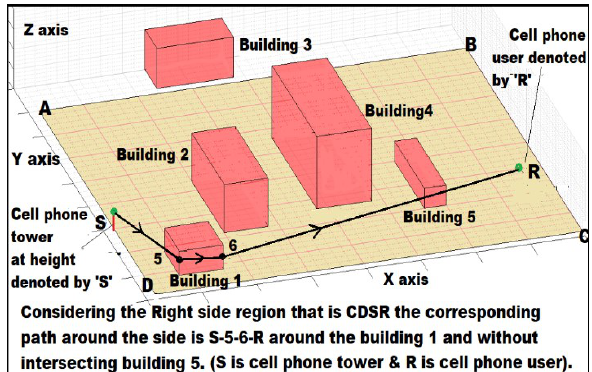
Figure 9. A signal path around the right side of the building